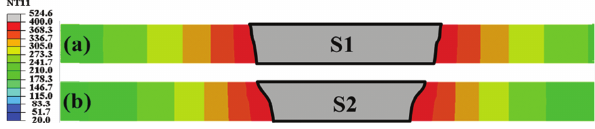
Figure 7: High temperature (exceed 400 ℃ ) area through the thick- ness of joint: (a) conventional cooling and (b) TIC.